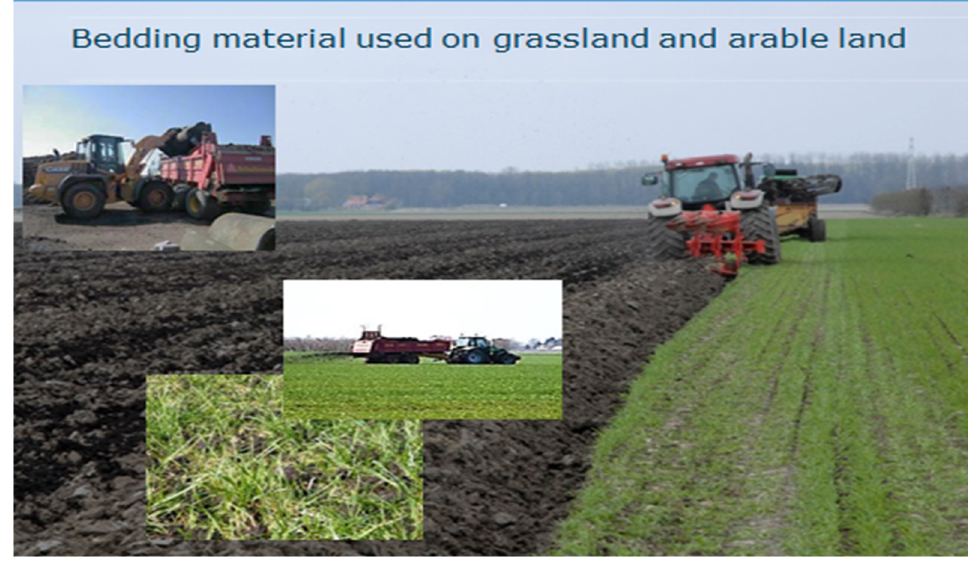
Figure 10. Bedding material spread on grassland and arable land. Source: